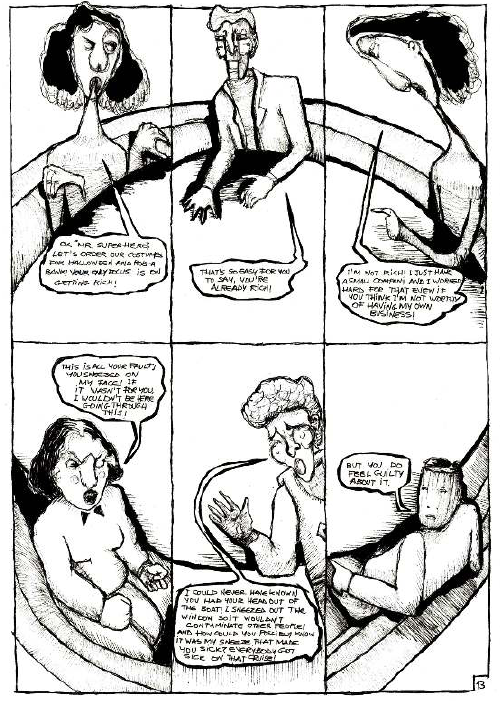
Credits: Amine Barbuda.